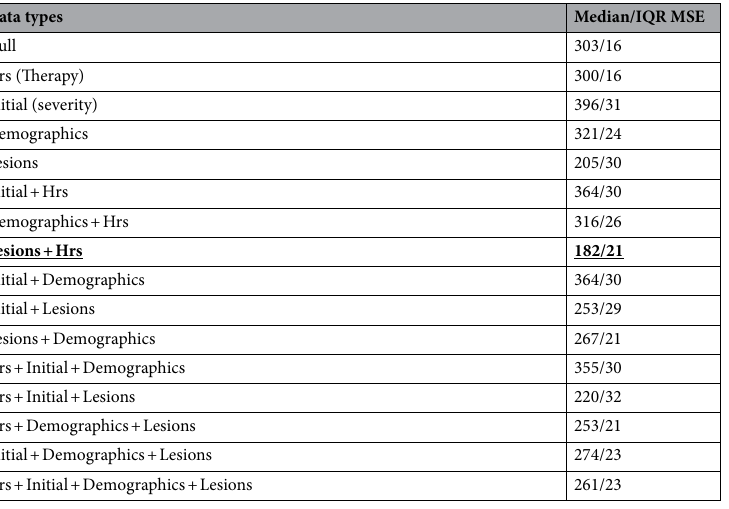
Table 1. Data configurations and predictive performance, as assessed across the same 1000 tenfold cross- validation runs. MSE mean squared errors of the model predictions; IQR inter-quartile range of the model predictions. These quantities are employed in preference to mean and standard deviation because MSEs typically have a Poisson distribution rather than a normal distribution. Lower MSEs imply more accurate predictions. The best model configuration is underlined (Hrs + Lesions): the most accurate predictions are derived from these